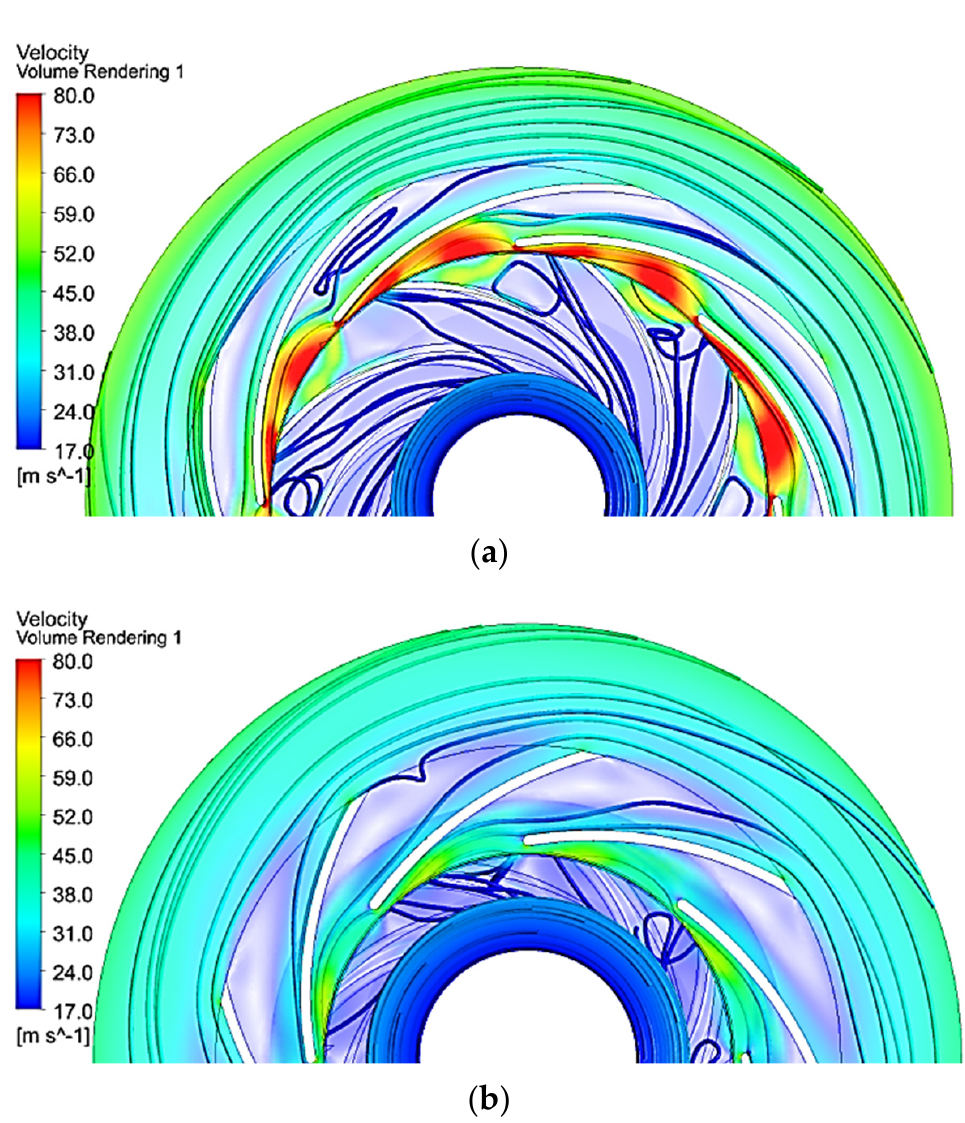
Figure 8. Counter-rotating stages: ( a ) reference (without trimming); ( b ) with trimming of 52 mm.